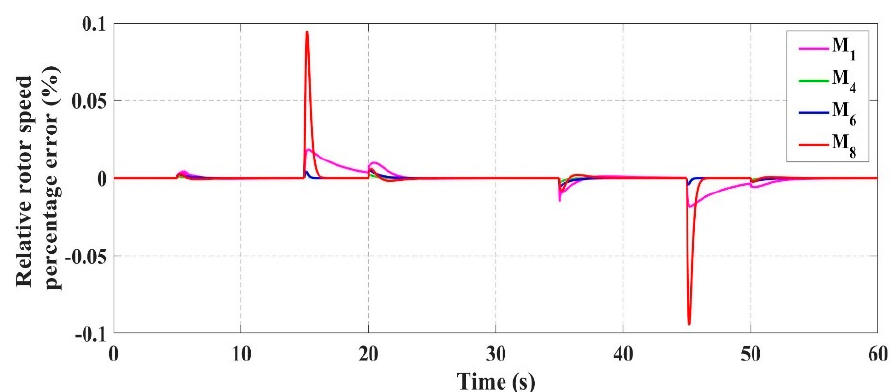
Figure 6. Relative rotor speed percentage errors (%).